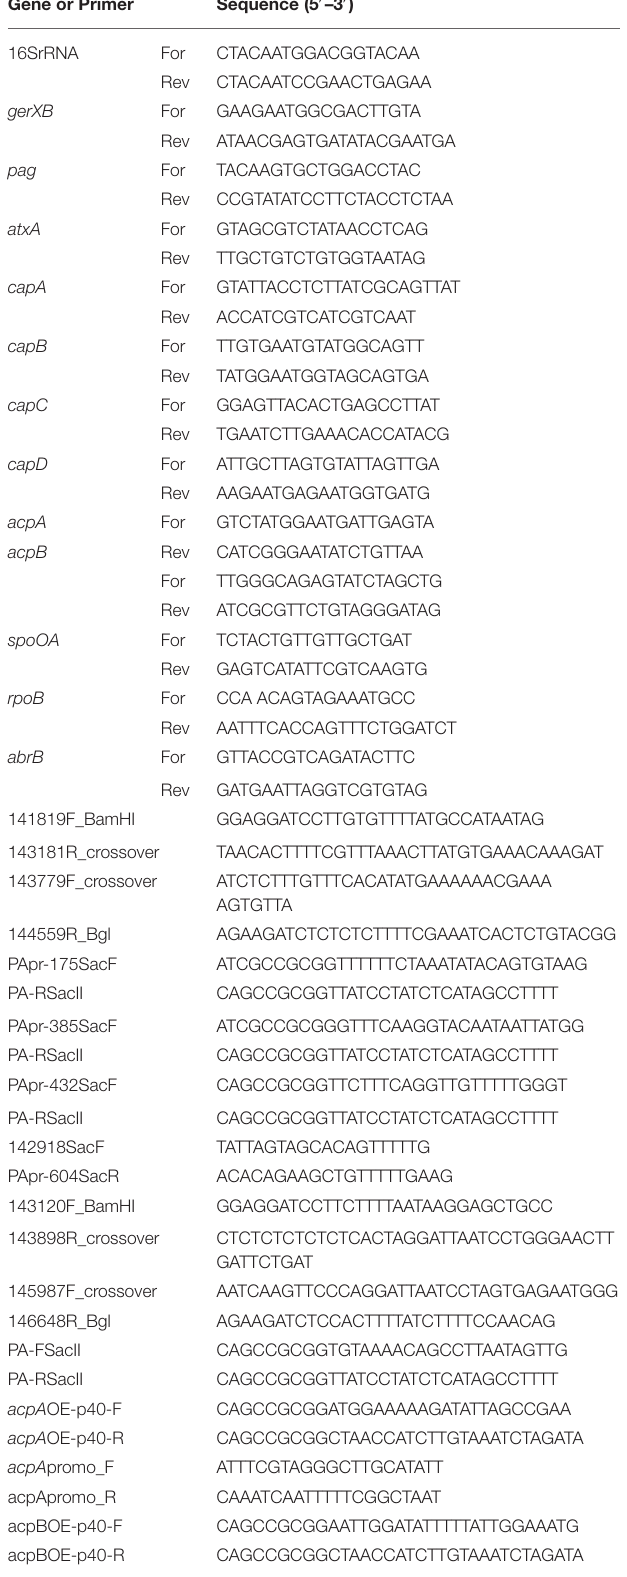
TABLE 1 | Oligonucleotides used in this